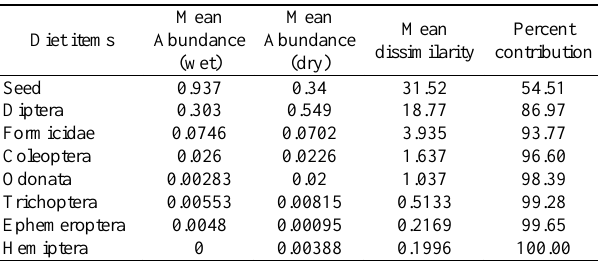
Table 2. Contributions of different diet items to the dissimilarity between dry and wet season diets based upon NMDS plot (Fig. 2). Average dissimilarity between groups = 87% (from SIMPER).